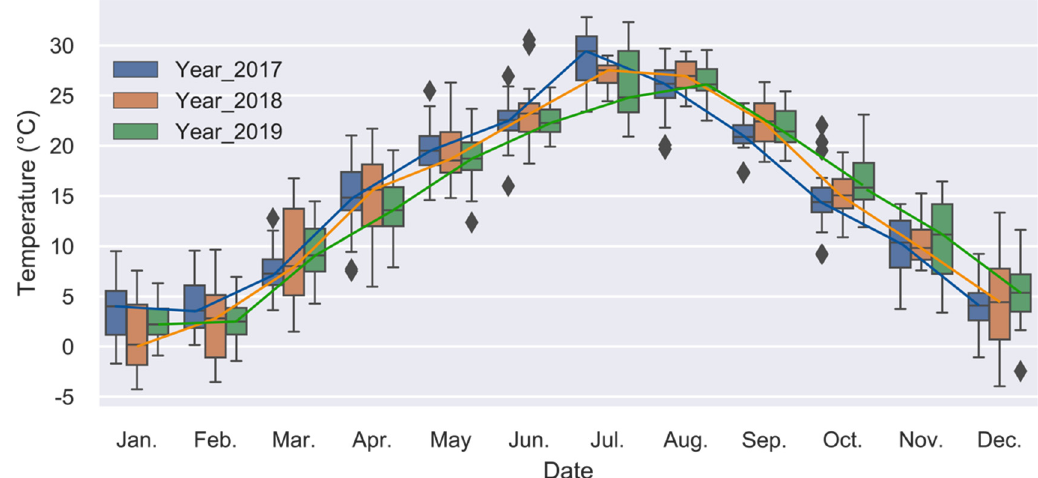
Figure A3. The distribution of minimum daily temperature for three years.